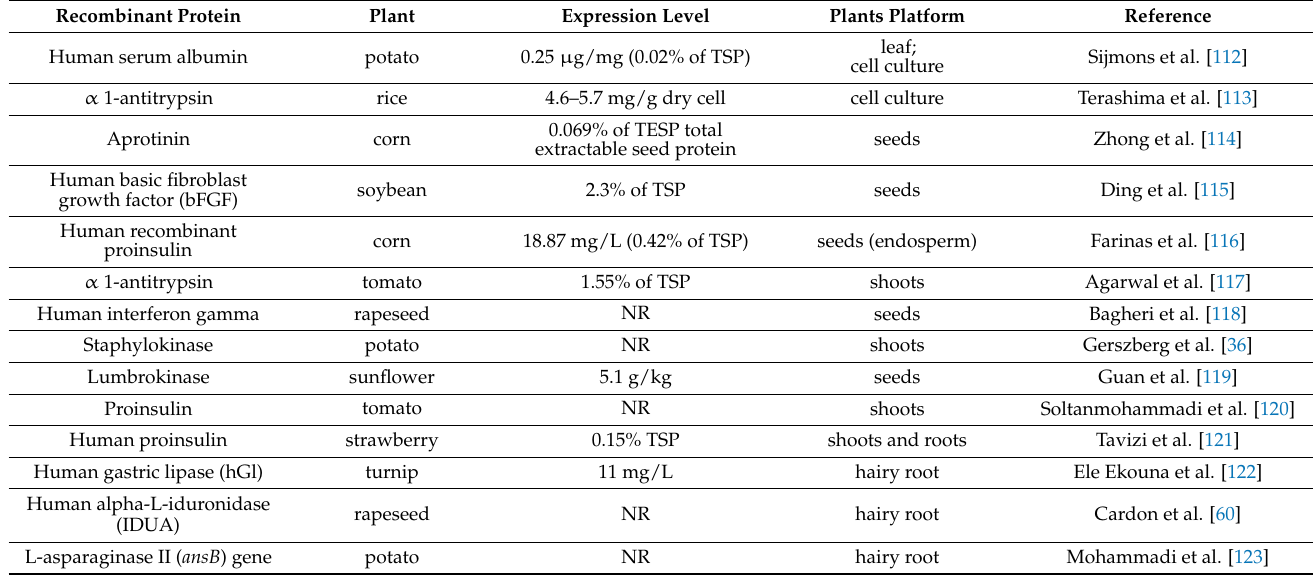
Table 3. Different recombinant proteins produced in crop